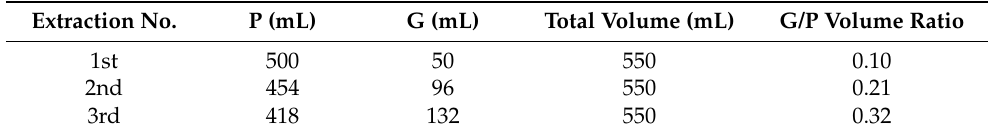
Table 3. The actual volumes of n-heptane (P) and xylene (G) in extractant solution, calculated from the concentration of G and P. 50 mL G and 500 mL P were sequentially added for each extraction. Solvents G and P of AR purity were used for the 1st extraction. G1 and P1 were used for the 2nd extraction while G2 and P2 were used for the 3rd